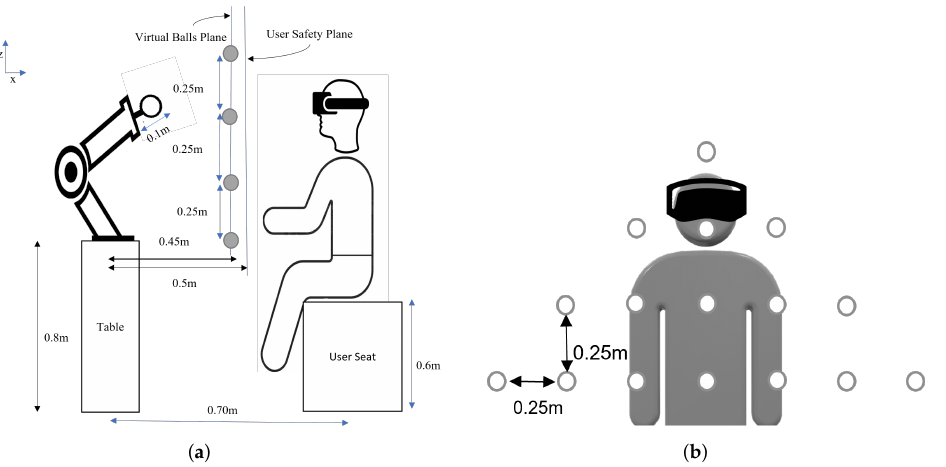
Figure 2. Experimental setup with the robot, the balls, and the user. ( a ) The side view. ( b ) The front